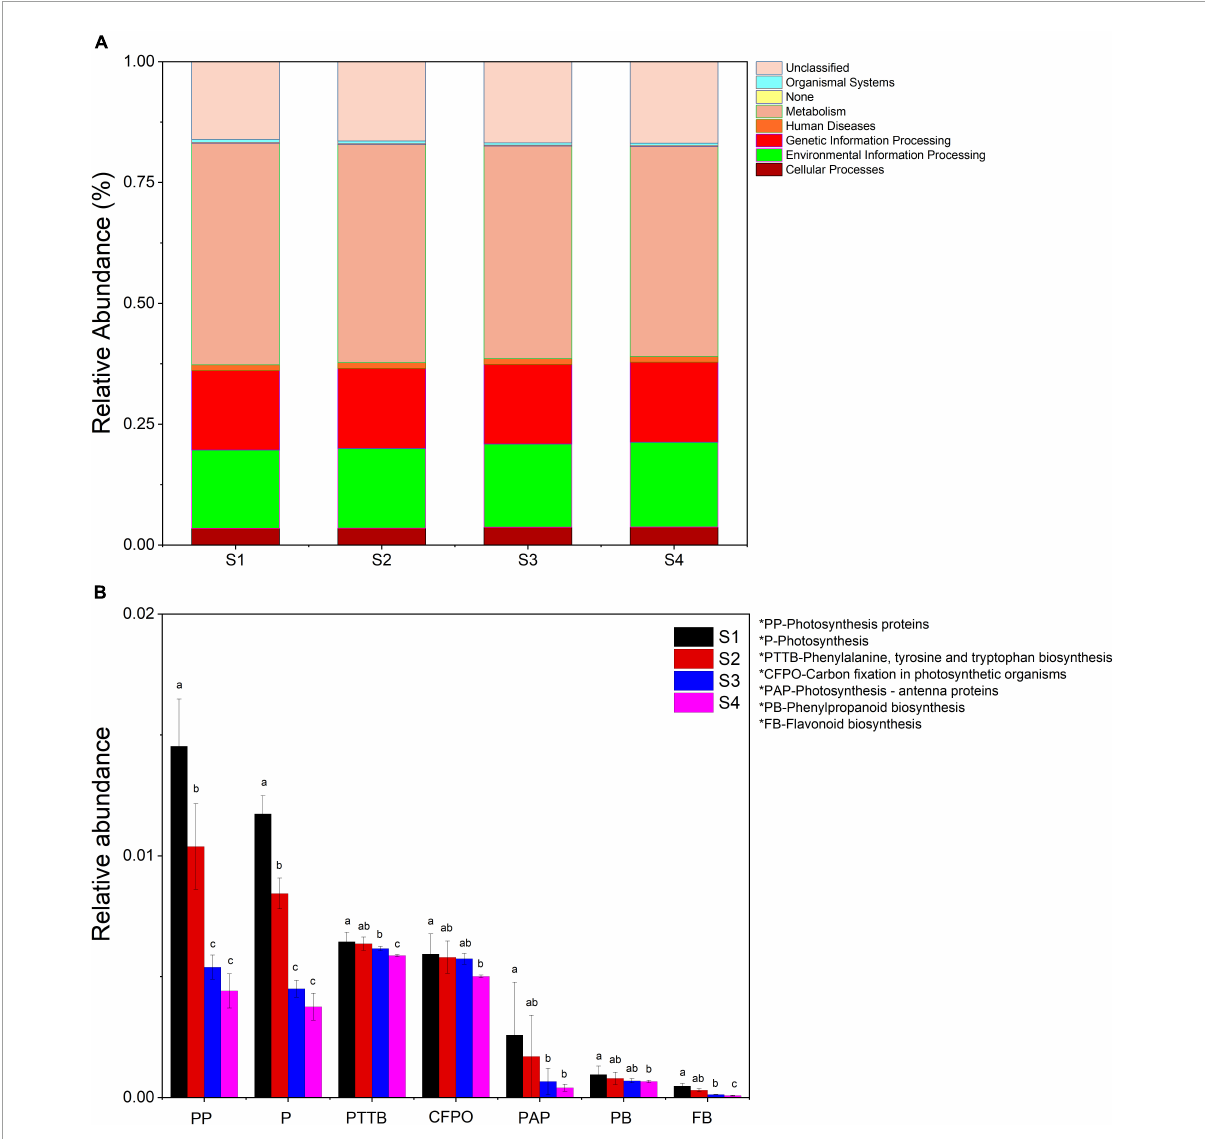
FIGURE6 (A) Relative abundance of predicted function genes in different levels I samples. (B) Changes in the relative abundance of predicted genes in the flavonoid synthesis and photosynthesis pathways in all samples. Samples with different letters indicated significant differences between samples ( p <